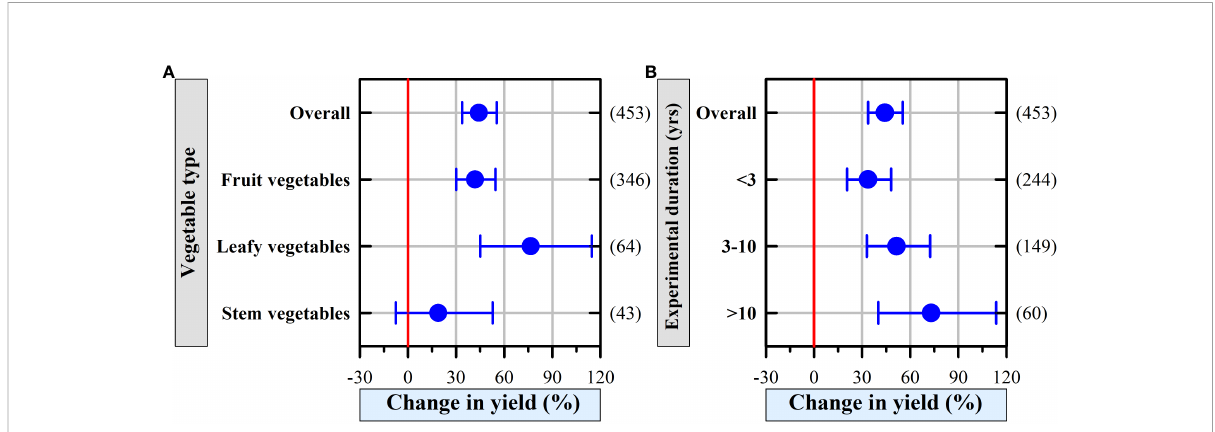
FIGURE 2 The effects of managerial factors (A) vegetable type and (B) experimental duration on greenhouse vegetable yield. The numbers of observations are shown right parentheses. The blue horizontal bars represent the 95% con fi dence intervals (CIs). If the CI does not overlap with 0 red line, which indicates a signi fi cant effect at P <